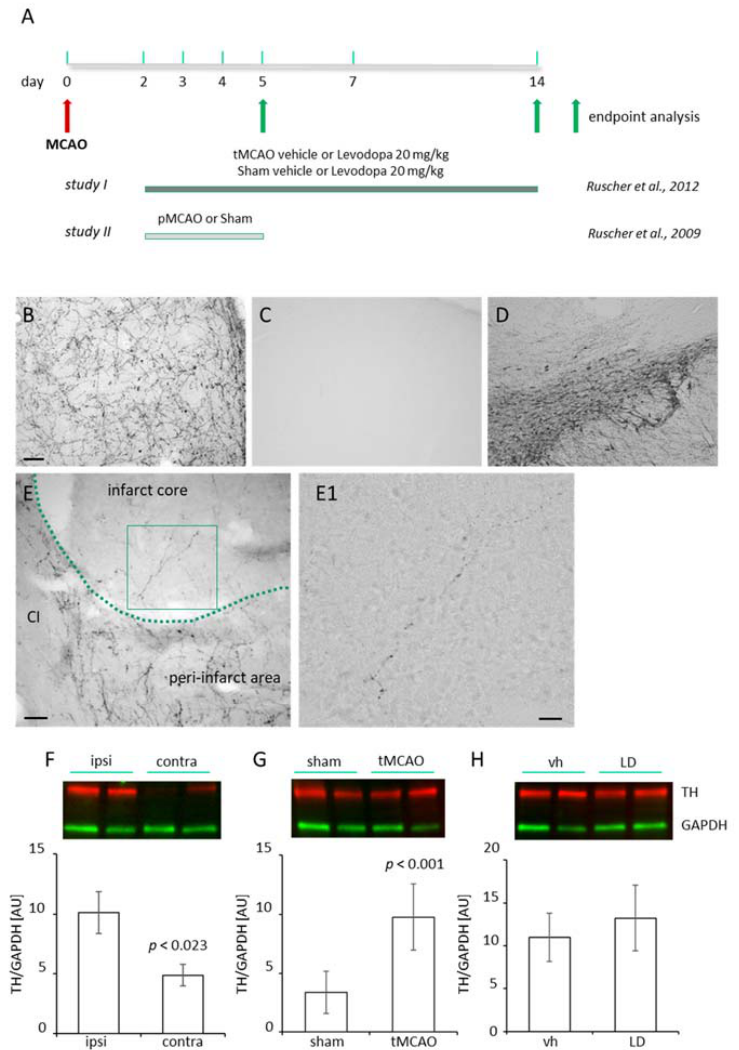
Figure 1. ( A ) Brain tissue sections and brain lysates from regions of interest were obtained from male Wistar rats subjected to transient or permanent occlusion of the middle cerebral artery (tMCAO/pMCAO) [13,22]. At the experimental endpoints (study I: 14 days; study II: 5 days) brains were either analyzed for dopaminergic innervation (study II), the Nogo A pathway, the number oligodendrocyte precursor cells and Growth-Associated Protein 43 (GAP 43) protein levels (study I). ( B ) Dopaminergic innervation in the peri-infarct area five days following pMCAO and ( C ) in the cortex of a sham-operated rat. ( D ) The ipsilateral Substantia nigra of the same animal shown in ( C ) as positive control for tyrosine hydroxylase (TH). Scale bars ( B – D )—100 µm. ( E ) Higher magnifica- tion of the proximal peri-infarct/infarct core border zone. The infarct border is delineated as a green dashed line. CI: capsula interna, scale bar: 50 µm. ( E1 ) Higher magnification of the insert of an indi- vidual TH positive branch shown in ( E ). Scale bar: 20 µm. ( F ) TH levels (red, StarbrightBlue 700) in the peri-infarct area ( n = 8) compared to the homotypic region of the contralateral cortex ( n = 8), 14 days after tMCAO in rats ( G ) TH levels in the somatosensory/motor cortex of sham operated rats ( n = 5) compared with rats subjected to tMCAO ( n = 6). ( H ) Levels of TH in the peri-infarct area of saline (vehicle; n = 8) and levodopa (LD 20 mg/kg; n = 8) treated rats, 14 days after tMCAO. Levels of TH have been normalized against glyceraldehyde 3-phosphate dehydrogenase (GAPDH, green, rhodamine). Statistical analysis was performed using Student’s t -test. p value < 0.05 was considered significant and differences are shown in respective figures.